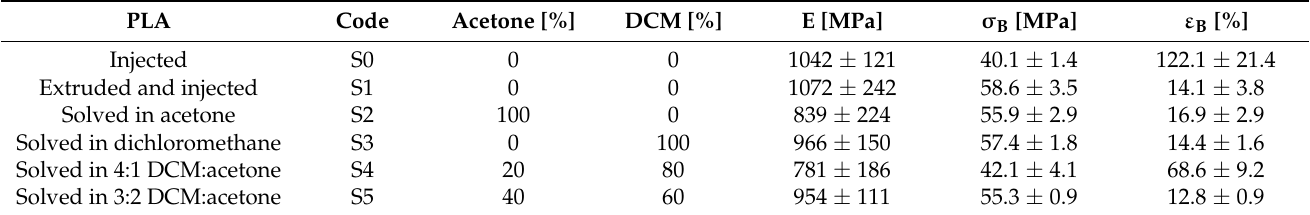
Table 2. Solvent optimization study samples composition and tensile strength results. (Where E refers to Young’s modulus, σ B is the stress at the breakpoint, and ε B the strain at the breakpoint).